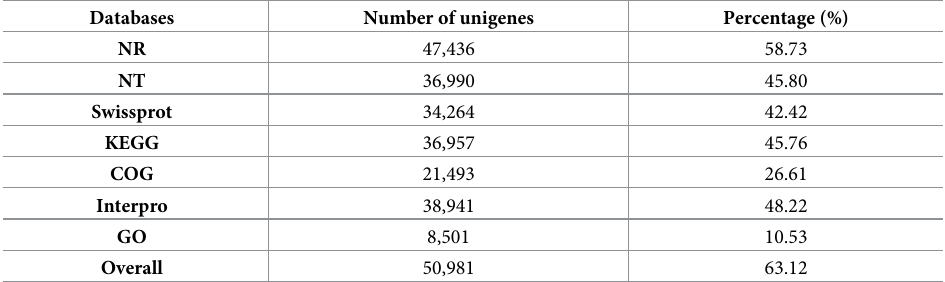
Table 3. Summary of functional annotations against major public databases. Overall: the number of unigenes which can be annotated in at least one functional database.